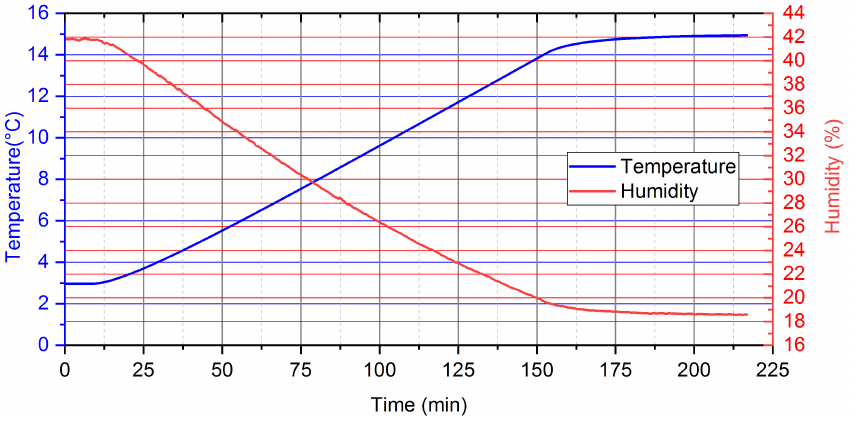
Figure 2. Temperature and relative humidity profiles maintained during